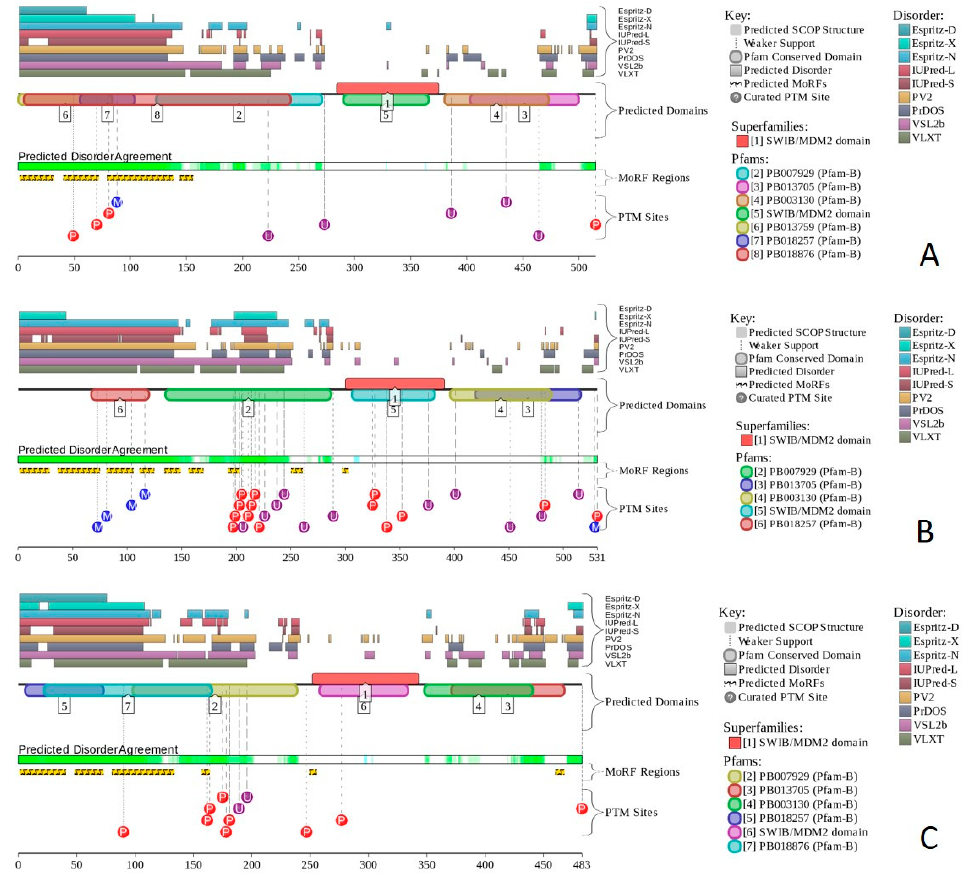
Figure 19. Structure, intrinsic disorder, and functionality of human BAF60A, BAF60B, and BAF60C proteins. ( A ) D 2 P 2 functional disorder profile of human BAF60A (UniProt ID: Q96GM5). ( B ) D 2 P 2 functional disorder profile of human BAF60B (UniProt ID: Q92925). ( C ) D 2 P 2 functional disorder profile of human BAF60C (UniProt ID: Q6STE5).